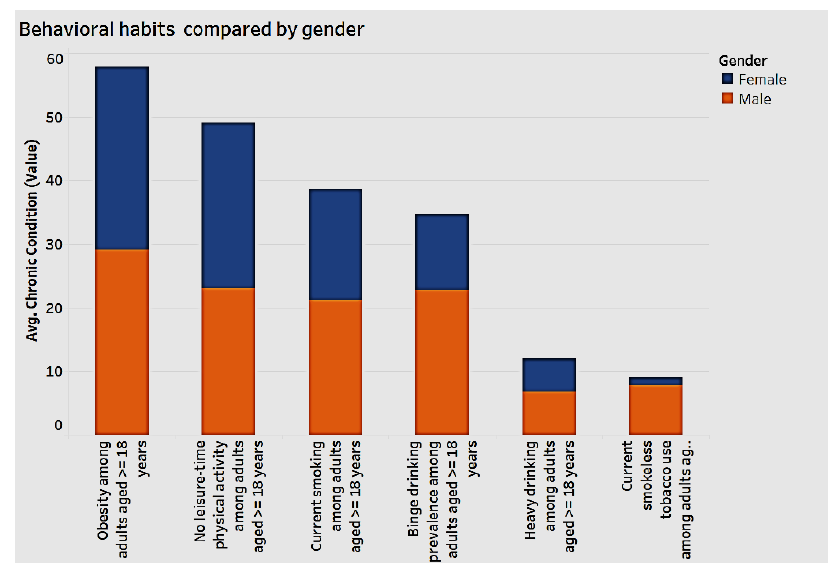
Figure 10. Behavioral habits by gender.